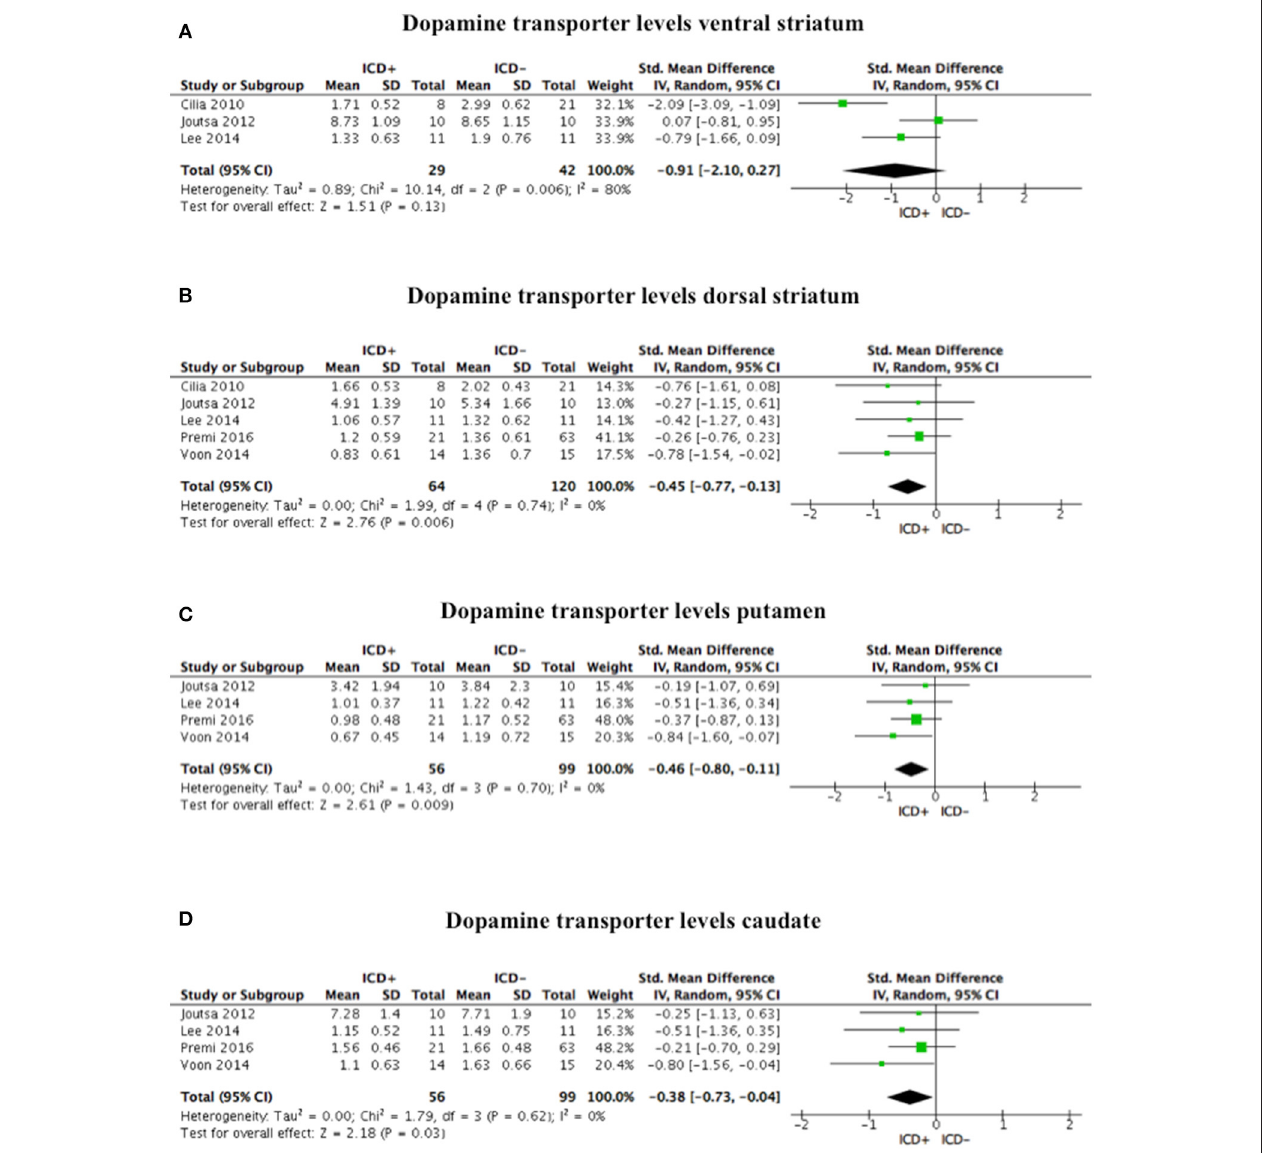
FIGURE 2 | Forest plots for dopamine transporter levels. Here are reported forest plots for dopamine transporter levels in the ventral striatum (A) , dorsal striatum (B) , putamen (C) , and caudate (D) . Standardized mean difference represents Hedges’s g effect size. The size of the square indicates the weight of the study. The horizontal line represents the 95% confidence interval. The diamond represents the pooled effect size. Negative effect sizes indicate lower dopamine transporter levels in PD patients with ICD (ICD + ) in comparison to those without ICD (ICD–). ICD, impulse control disorder; PD, Parkinson’s